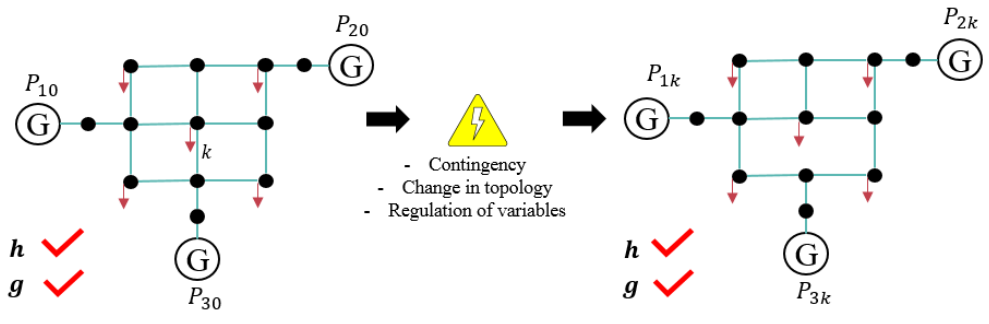
Figure 1. Interpretation of the CCOPF problem in a hypothetical network in steady